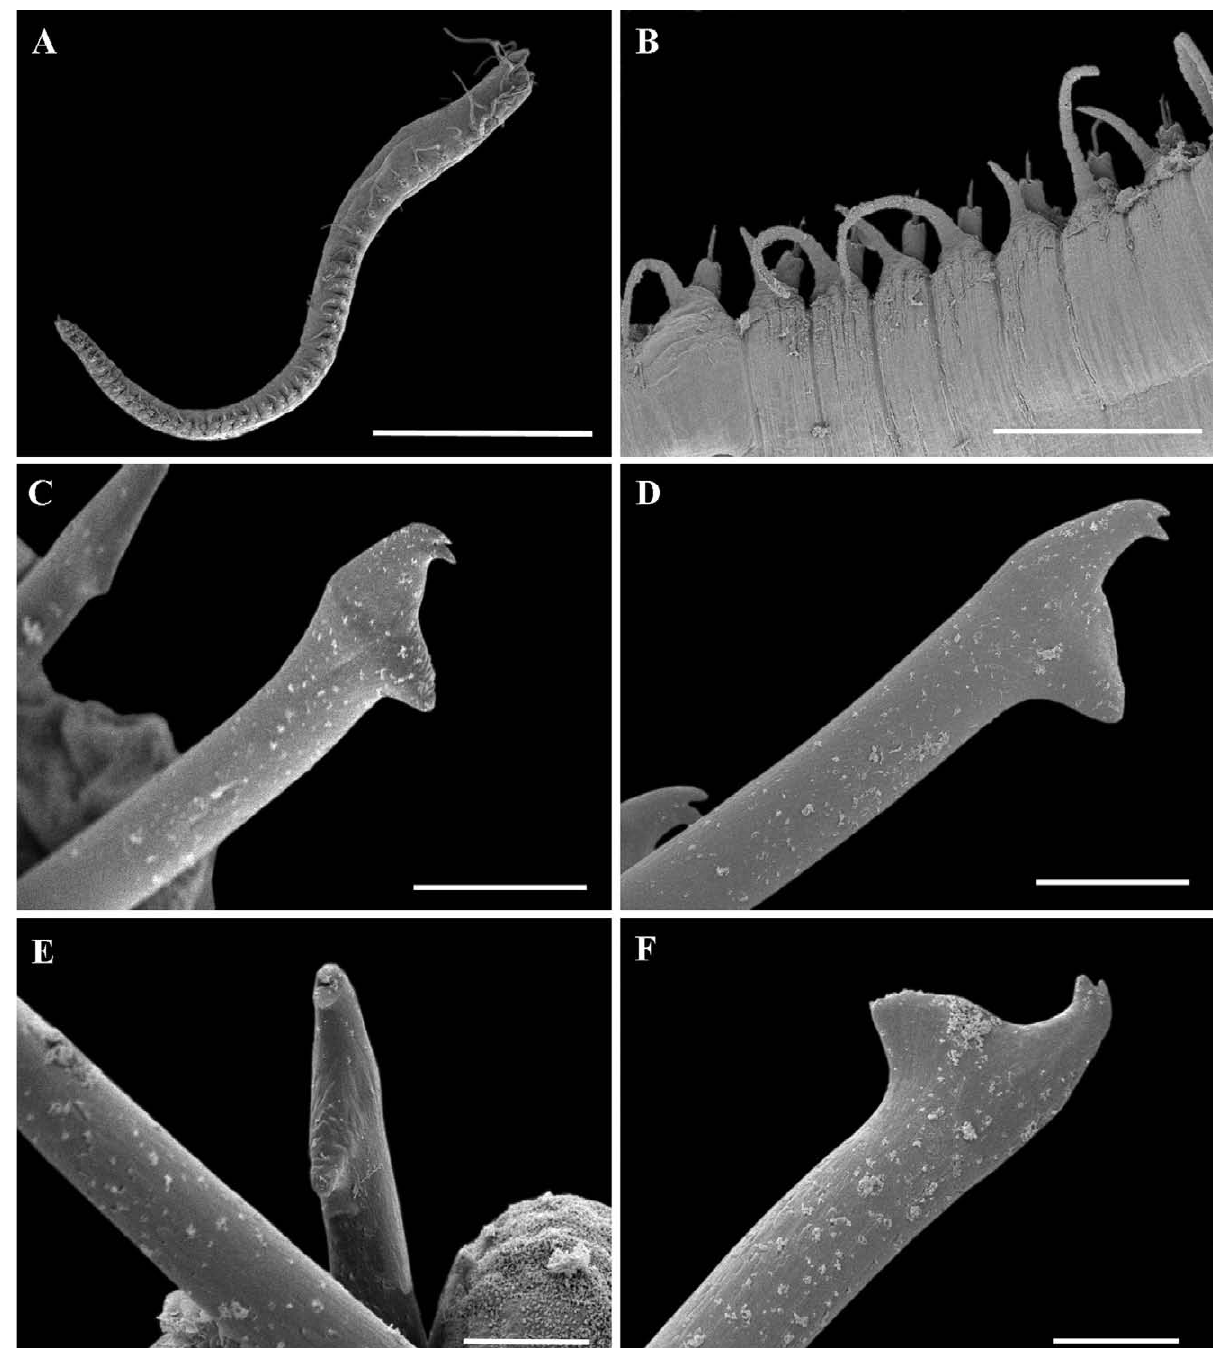
Fig . 10. – SEM micrographs of Haplosyllis chaetafusorata n. sp. A, whole body, lateral view. B, mid-body parapodia, alternating long and short cirri. C, anterior chaetae, chaetiger 4. D, mid-body chaetae. E, mid-body small chaetae, lateral view. F, posterior chaeta. Scale bars: